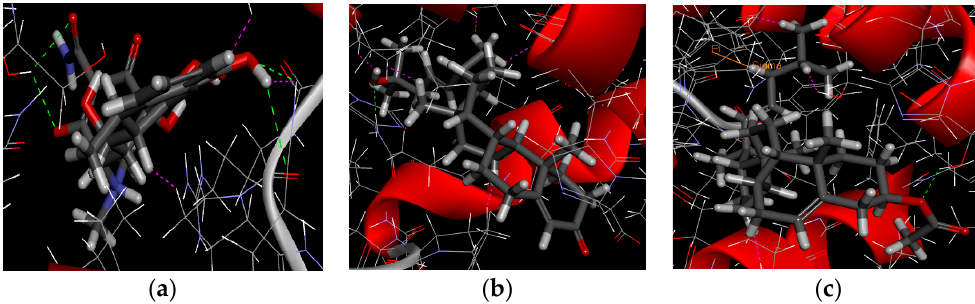
Figure 10. 3D docking of ligand–receptor interactions with doxycycline as a control. ( a ) The graphical representation of 3D interaction of doxycycline and receptor protein 2XRL; ( b ) the graphical representation of 3D interaction of compound 1 and receptor protein 2XRL; and ( c ) the graphical representation of 3D interaction of compound 2 and receptor protein 2XRL.